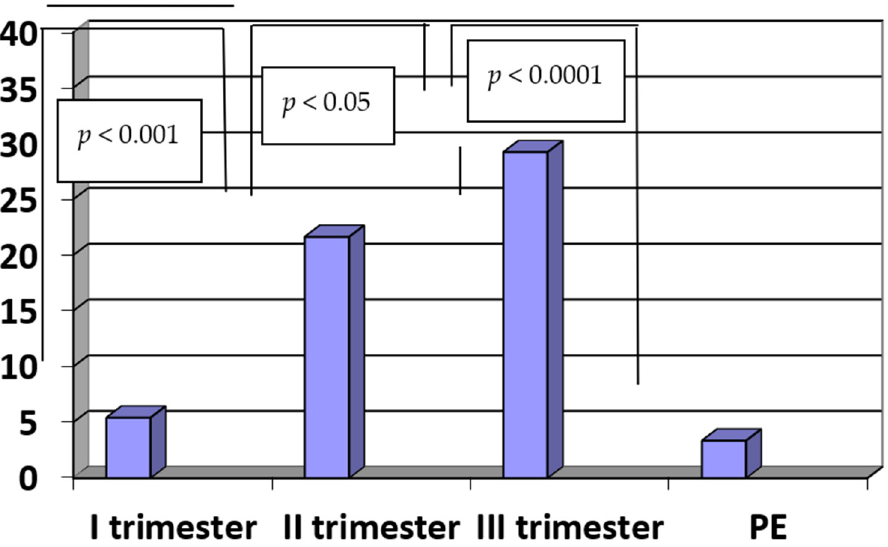
Figure 3. The concentrations of PlGF (pg/mL) in sera of patients with PE (n = 35) and in sera of women in the first, second and third trimesters of normal pregnancy (n = 45).